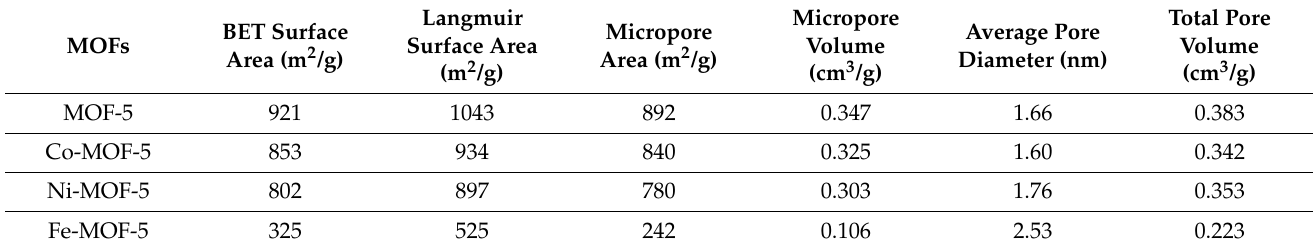
Table 1. Surface area and pore parameters of MOF-5 and M-MOF-5 samples.